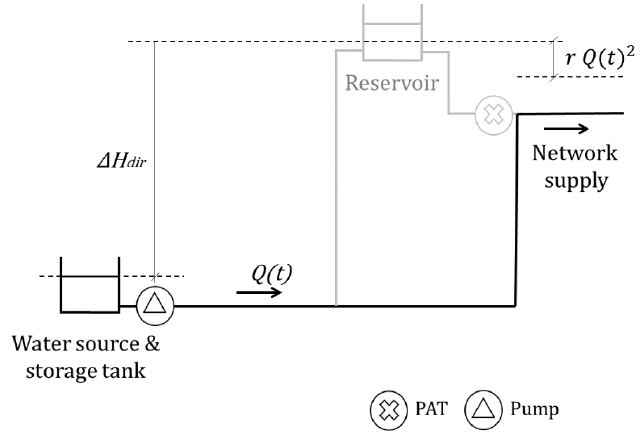
Figure 4. Scheme of direct pumping.